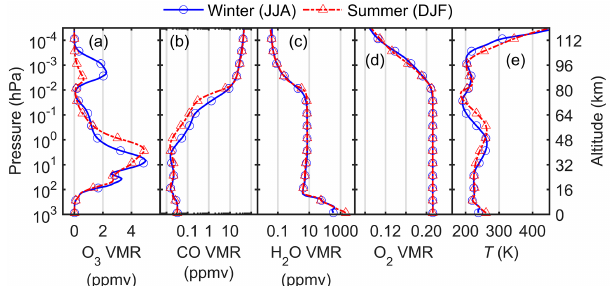
Figure 3. Seasonal mean winter (JJA, solid blue line) and summer (DJF, dashed red line) atmospheric profiles for (a) O 3 VMR, (b) CO VMR, (c) water vapour VMR, (d) O 2 VMR, and (e) temperature from SD-WACCM simulation data.